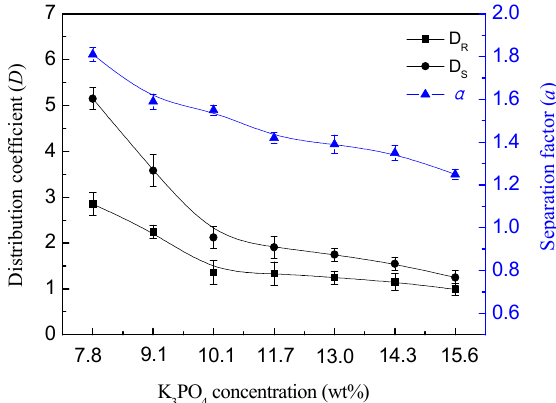
Figure 4. Effect of K 3 PO 4 concentration to the chiral extraction of phenylalanine enantiomers. The extraction conditions were as follow: 30 wt% [Ch][L-Pro], 40 mmol/L HP- β -CD, 15 mg/mL phenylalanine. The extraction experiments were done at room temperature and without adjusting the system pH.